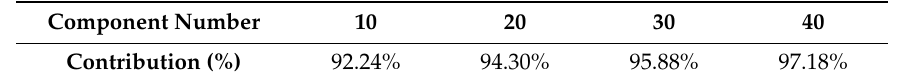
Table 7. The contribution (%) to variance explained by different number of principle components.